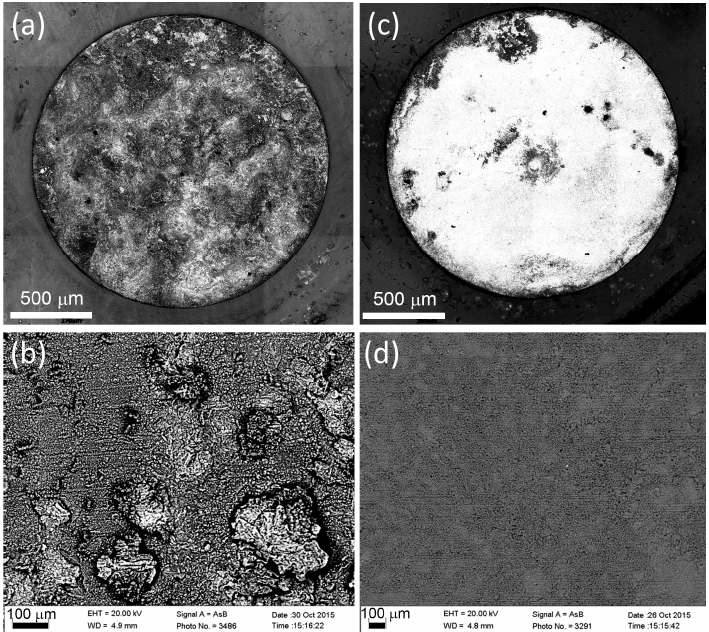
Figure 4. Microscopy images showing the surface morphology of the Mg alloy specimens after corrosion testing in the 0.9% NaCl solution for 24 h: ( a ) and ( b ) ZK60, ( c ), and ( d ) WZ21; ( a ) and ( c ) optical view, ( b ) and ( d ) SEM images. Corrosion products were removed before observation.